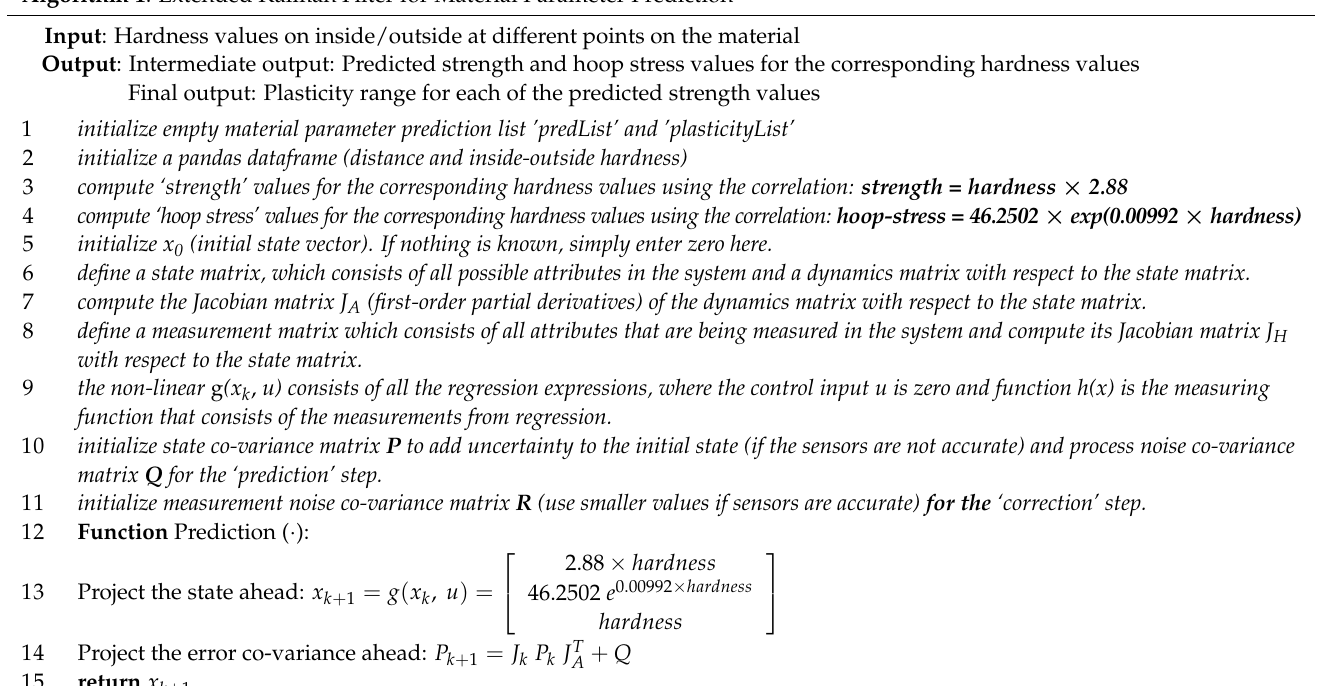
Algorithm 1 : Extended Kalman Filter for Material Parameter